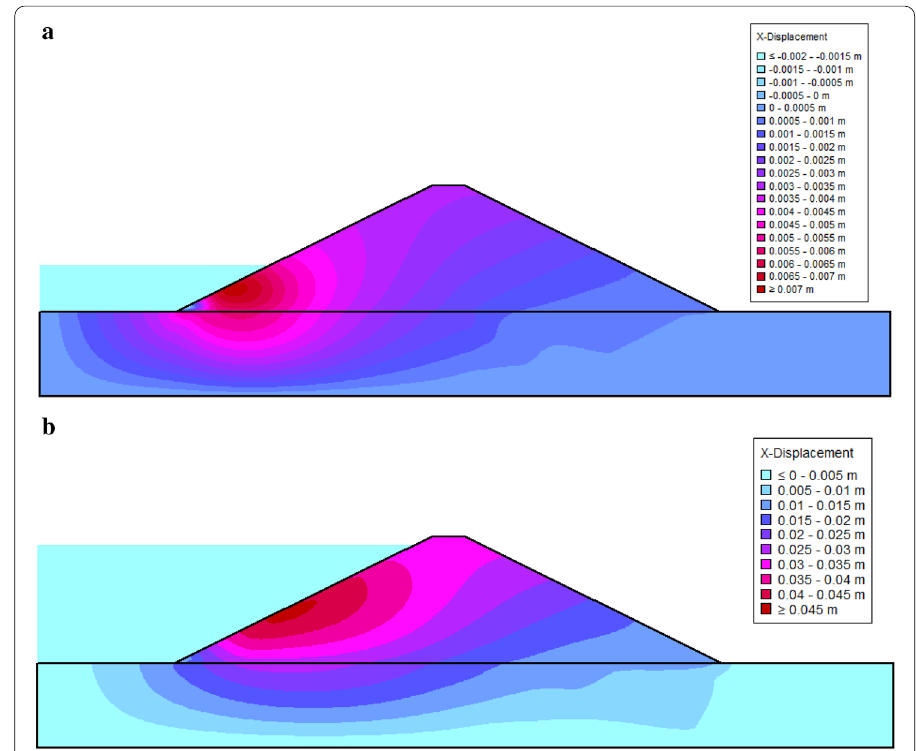
Fig. 15 Horizontal displacement contours within the earthen dam and foundation during the reservoir rise-up condition at the a 2nd day, b 5th